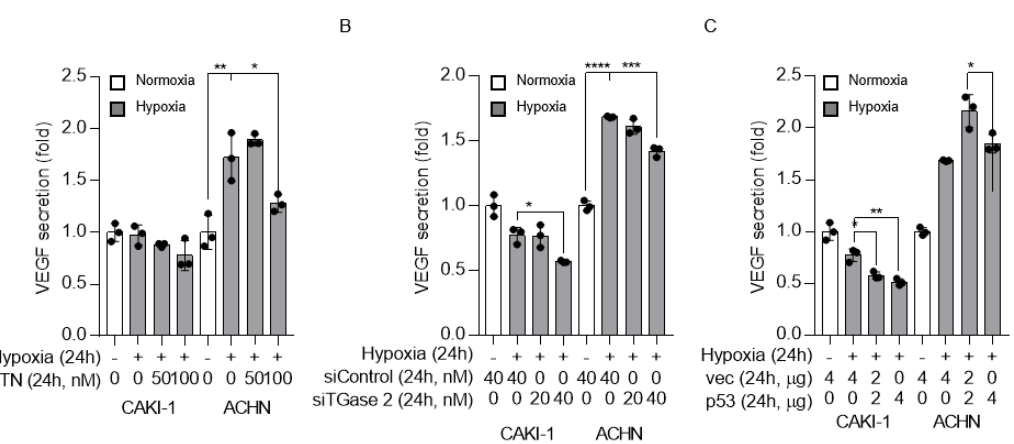
Figure 4. TGase 2 inhibition and p53 overexpression decrease vascular endothelial growth factor (VEGF) secretion under hypoxia. ( A ) VEGF (pg / mL) secretion into the cell culture supernatant was assessed by ELISA. Cells were treated with STN and incubated in serum-free medium under hypoxia (1% O 2 ) for 24 h. ( B ) Cells were transfected with control or TGase 2 siRNA and incubated in serum-free medium under hypoxia (1% O 2 ) for 24 h. VEGF levels were determined by ELISA. ( C ) Cells were transfected with plasmid encoding wild-type p53 cDNA and incubated in serum-free medium under hypoxia (1% O 2 ) for 24 h. VEGF levels were determined by ELISA. The secreted VEGF amount (absorbance) is used to normalize the sulforhodamine B assay (absorbance). Sulforhodamine B assay in cell culture to investigate cell proliferation. Error bar represents SD. GraphPad Prism software used to perform one-way ANOVA, ** p < 0.01, *** p < 0.001, **** p < 0.0001. Data are representative of three independent experiments.